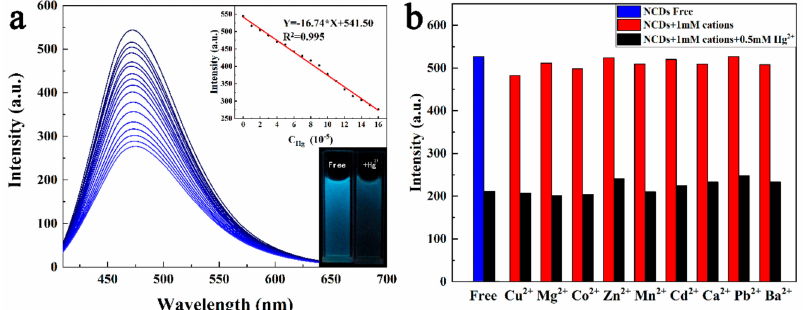
Figure 7. ( a ) FL emission spectra of the N-CDs (0.05 mg mL − 1 ) upon exposure to various concentrations of Hg 2 + (from top to bottom: 0, 10, 20, 30, 40, 50, 60, 70, 80, 90, 100, 110, 120, 130, 140, 150, 160 µ M) in aqueous solution excitation at 400 nm; Inset 1 (bottom right corner) shows the fluorescence images of the N-CDs in aqueous solution in the absence and presence of Hg 2 + ion under UV light of 254 nm. Inset 2 (top right corner) shows the calibration curves and linear equation for FL intensity and concentration of Hg 2 + . ( b ) The selectivity test of N-CDs (0.05 mg mL − 1 ) for Hg 2 + against di ff erent metal ions.